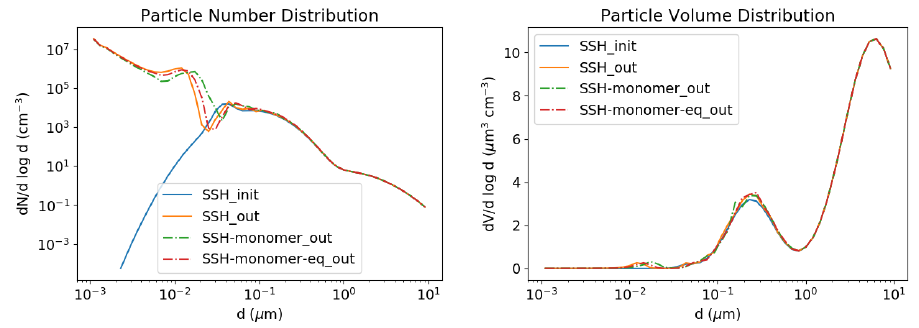
Figure 11. Nucleation test case. Number ( left ) and volume ( right ) concentrations. The initial concentrations are in blue; the simulated concentrations without Monomer are in orange and with Monomer in green. The simulated concentrations with Monomer but solving condensation after coagulation every 60 s are in red.